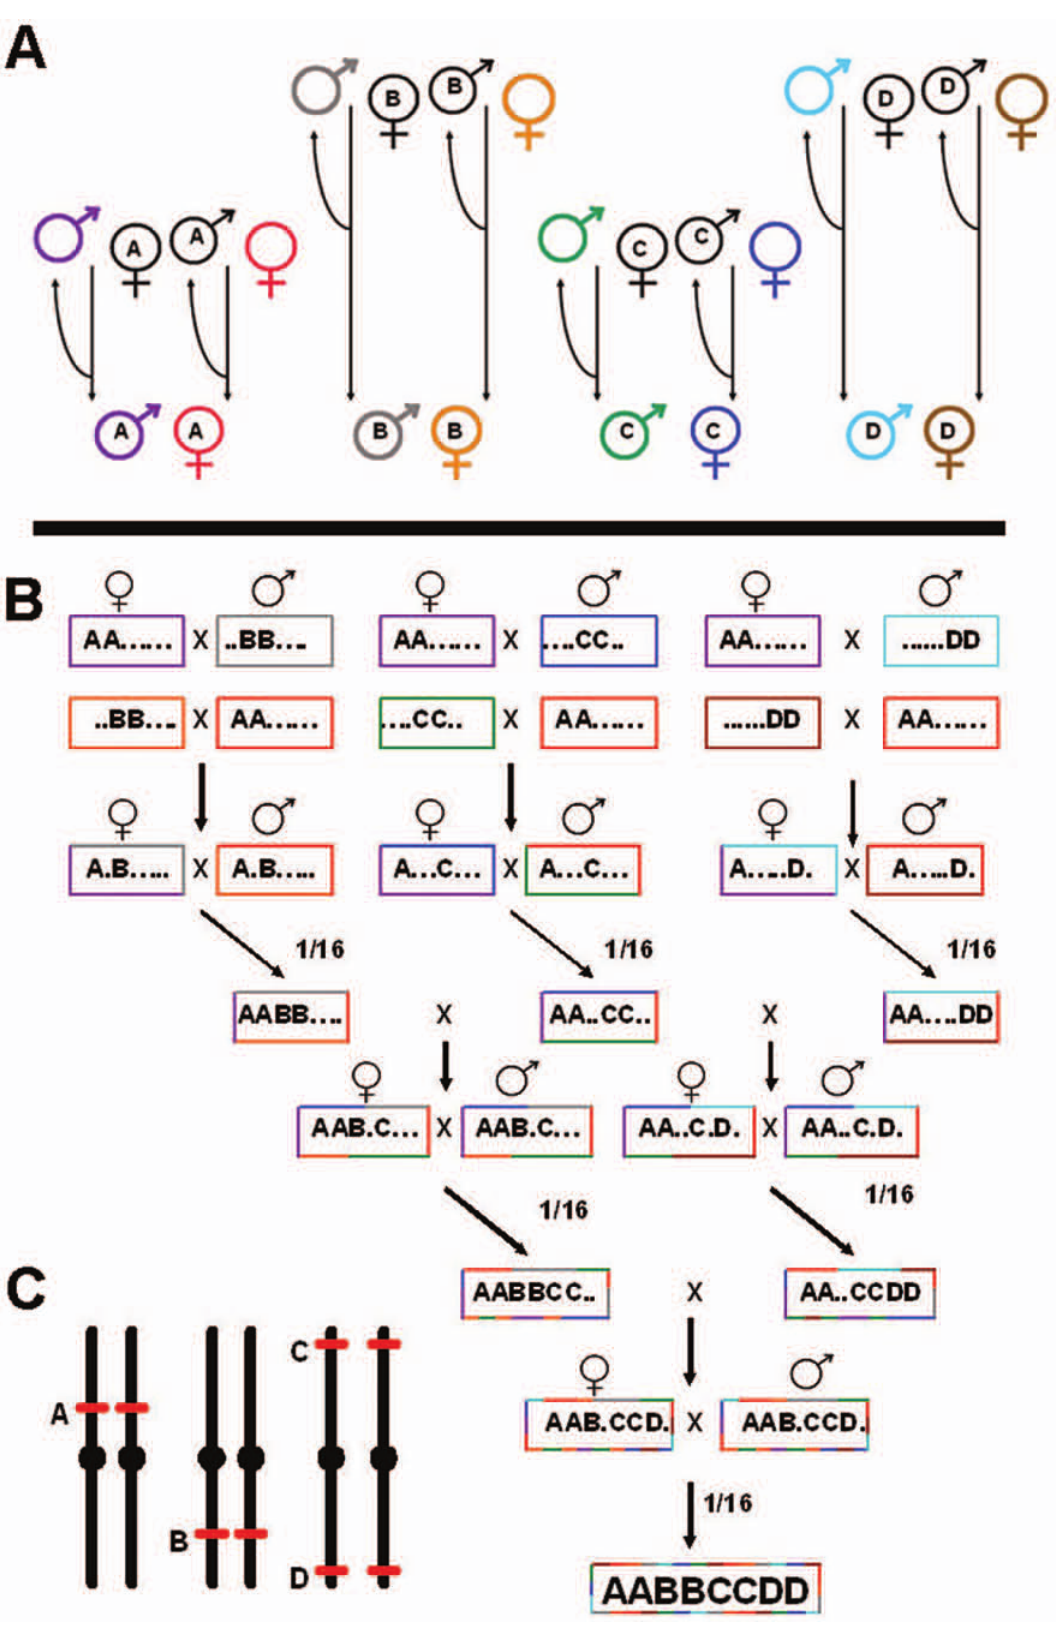
Figure 1. Crossing scheme to create an MLA mosquito strain. A: Each transgenic line (A–D) is outcrossed to one of two wild-type backgrounds (denoted by colors). The final 8 outcrossed transgenic lines are made homozygous. B: The 8 outcrossed transgenic lines are specifically